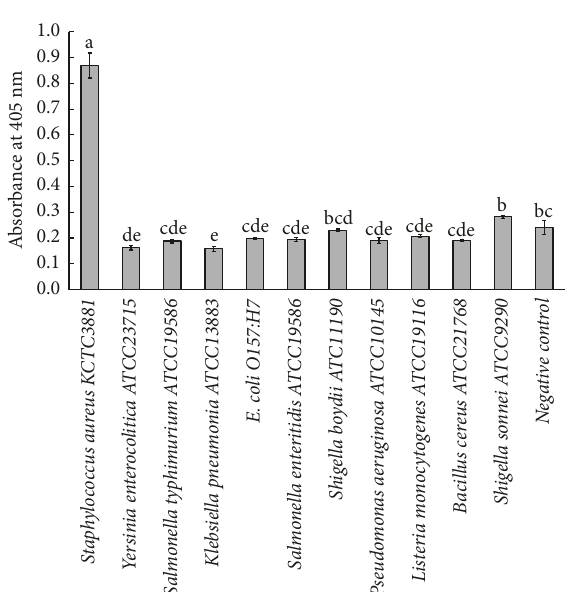
Figure 2: The specificity of custom prepared anti- Staphylococcus aureus polyclonal antibodies with selected bacterial strains deter- mined by indirect ELISA. Error bars represent standard deviation ( 𝑛 = 3 ). Different superscript letters (a–e) represent significant dif- ferences among the samples at 𝑃 < 0.05 .